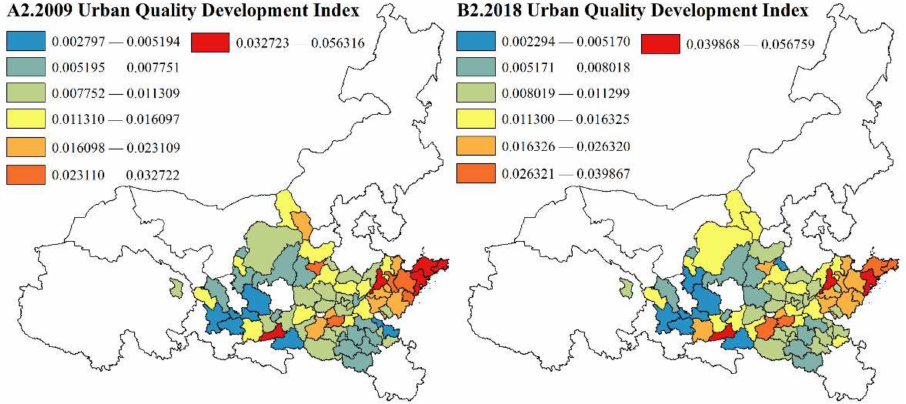
Figure 4. Spatial change in the HQD level of cities in 2009 and 2018.